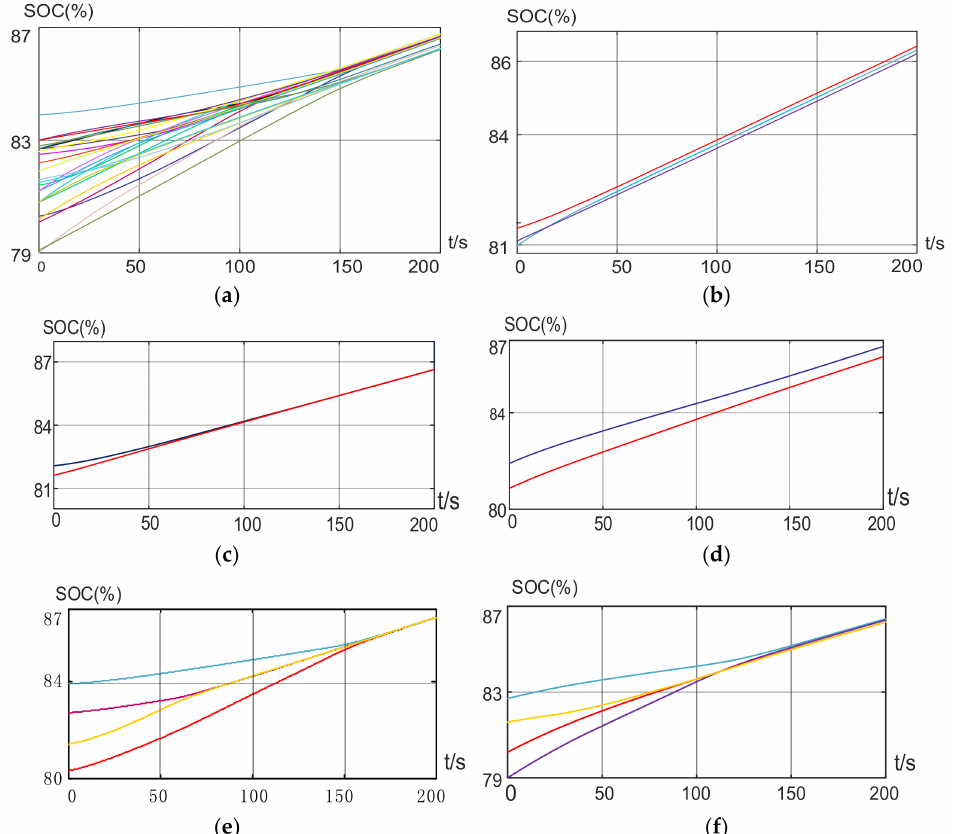
Figure 11. Three-level SOC balancing without power adjustment in charge mode. ( a ) The SOC of all 24 battery modules. ( b ) The SOC balancing among the three phase legs. ( c ) The SOC of upper and lower arm within phase A. ( d ) The SOC of upper and lower arm within phase B. ( e ) Submodule SOC of upper arm in phase A. ( f ) Submodule SOC of upper arm in phase B.